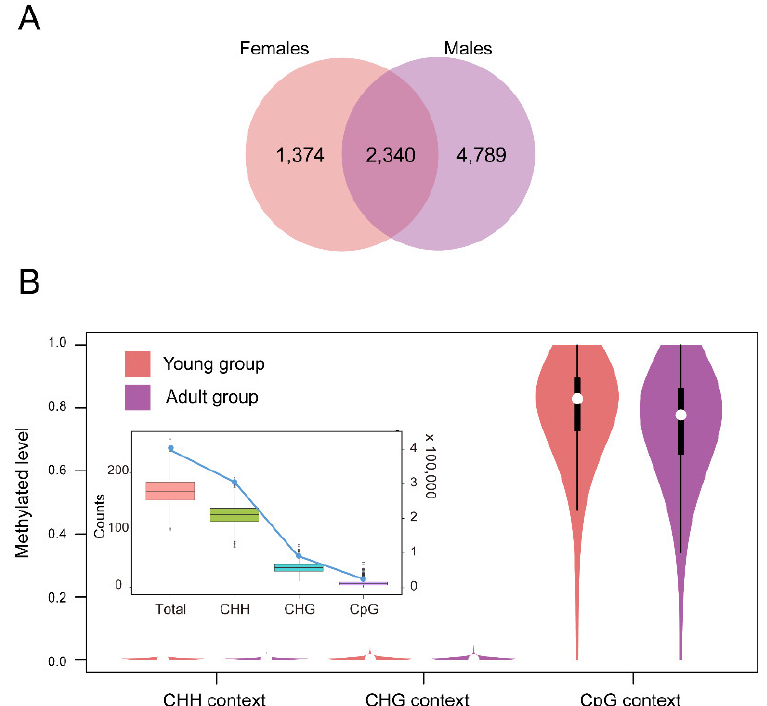
Figure 5. Distribution of promoter methylation in two groups. ( A ) Venn diagram depicting promoter regions and shared promoter regions based on gender. ( B ) Boxplot depicting the counts of the CHH context, CHG context and CpG context according to the reference genome. Vioplot chart depicting the CHH context, CHG context and CpG context of 2340 shared promoters’ distribution across the two groups.